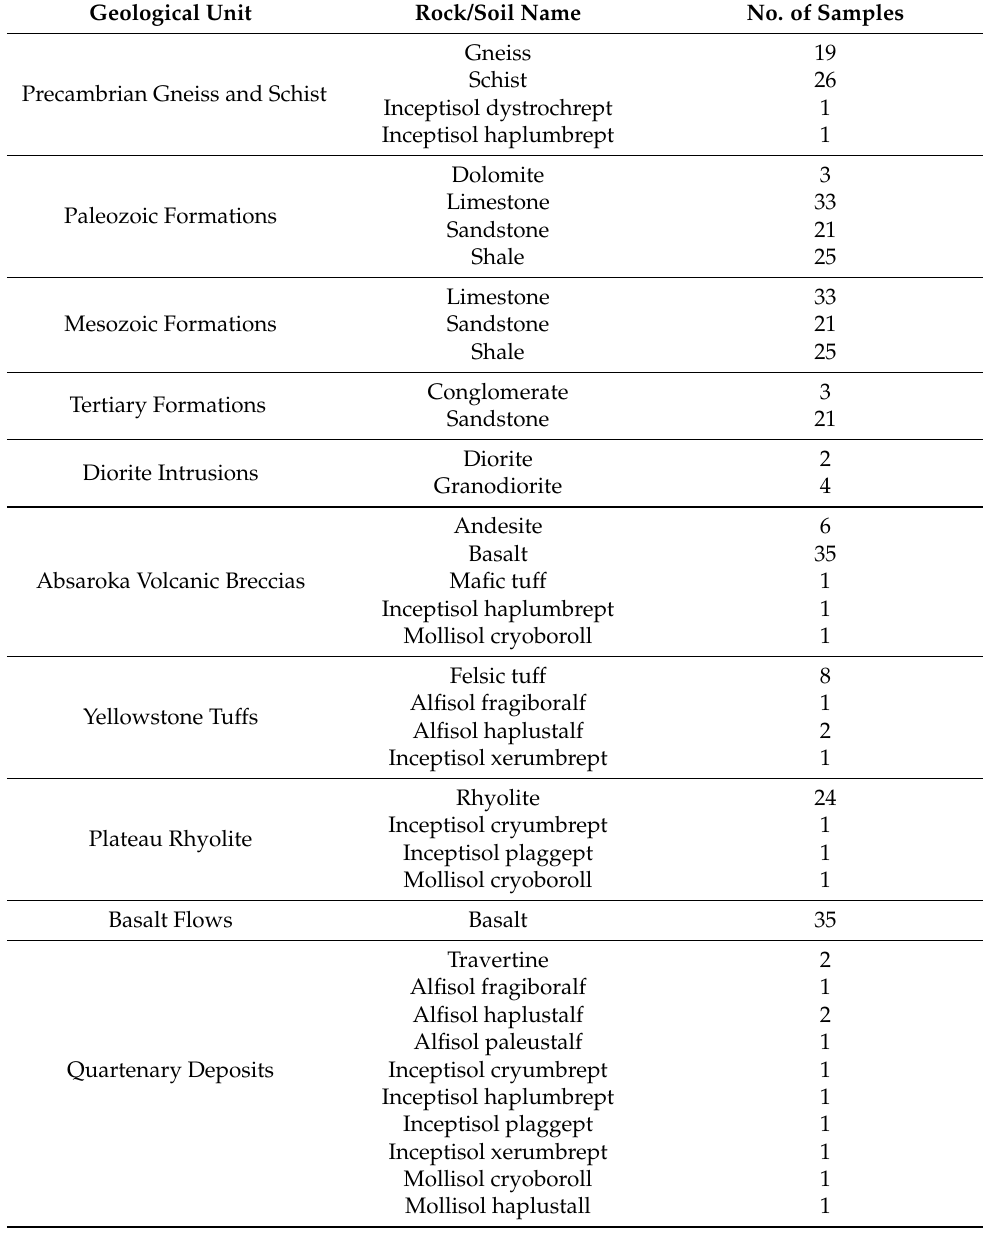
Table 2. Overview of substrate samples used in the analysis. More detailed descriptions of the samples can be found in the ECOSTRESS library